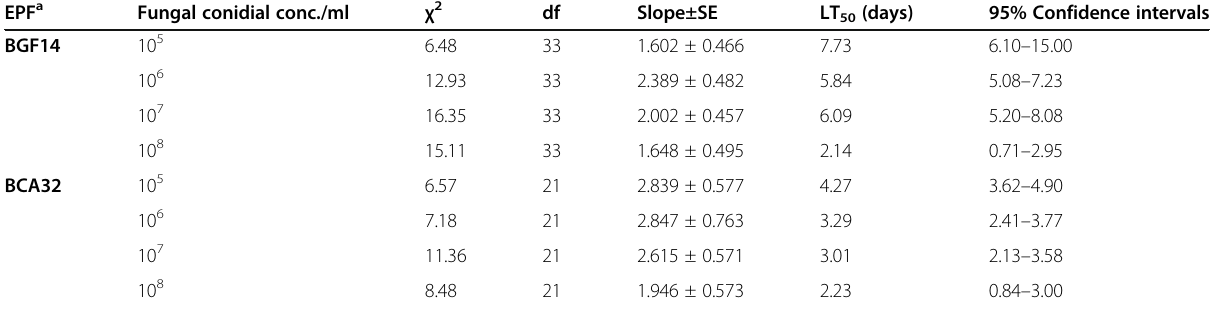
Table 3 Median lethal time (LT 50 ) values of BGF14 and BCA32 isolates of Beauveria bassiana against Tetranychus urticae adults EPF a Fungal conidial